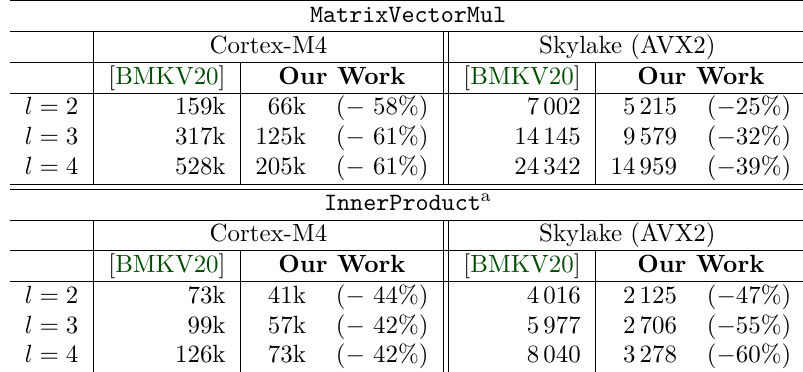
Table 5: Saber Performance results in clock cycles for core arithmetic operations on Cortex-M4 and Skylake. The Inner-product computation in our AVX2 implementation for SABER does not contain the cost of computing the NTT of one of the input